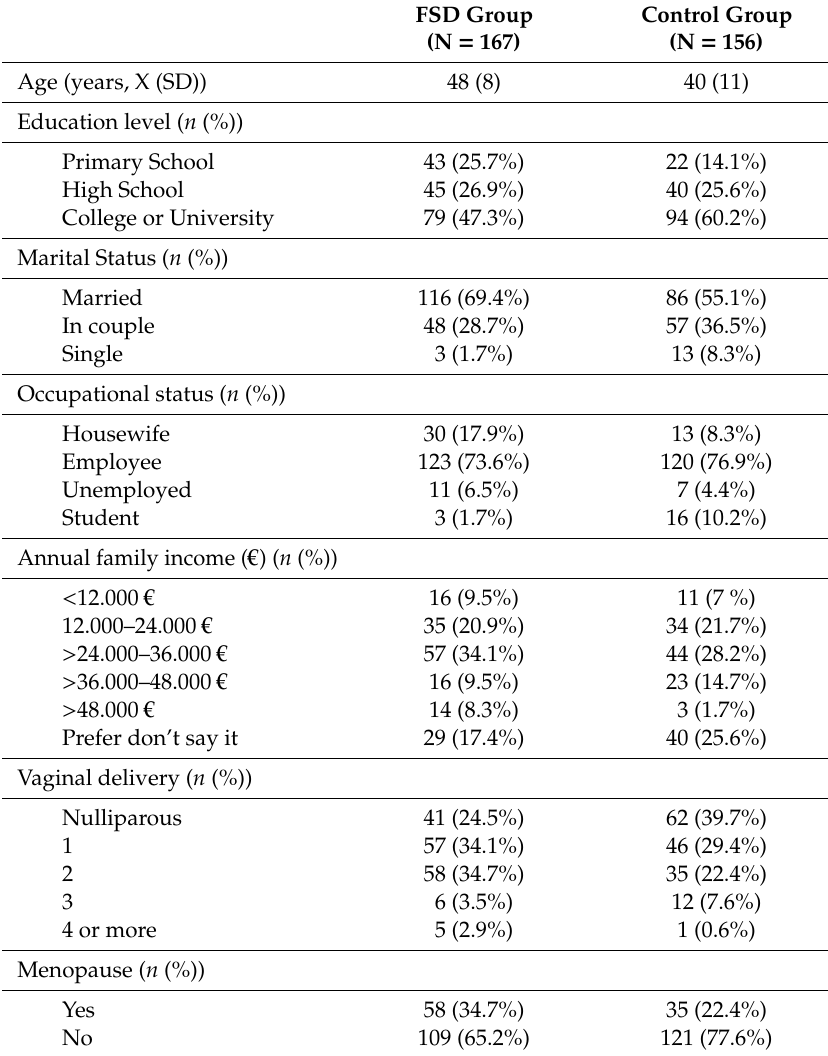
Table 1. Baseline characteristics of